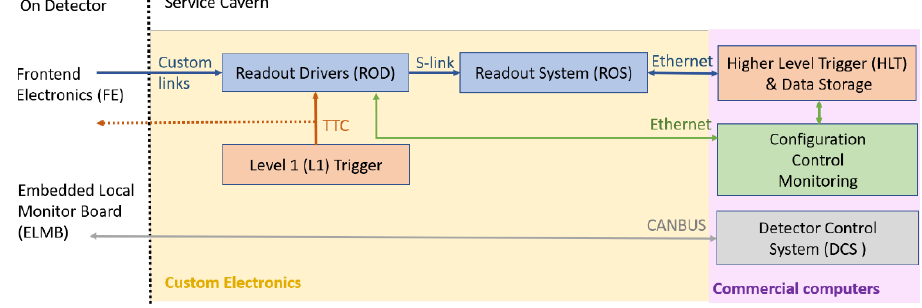
Figure 1. The current ATLAS Readout System. Custom designed Readout Drivers (ROD) and Readout System (ROS) forwards data from the front-end electronics of the detector to commercial computers running dedicated software. The dedicated software includes functionalities such as Data Storage, configuration, control and monitoring of the detector as well as High-Lever Trigger (HLT).